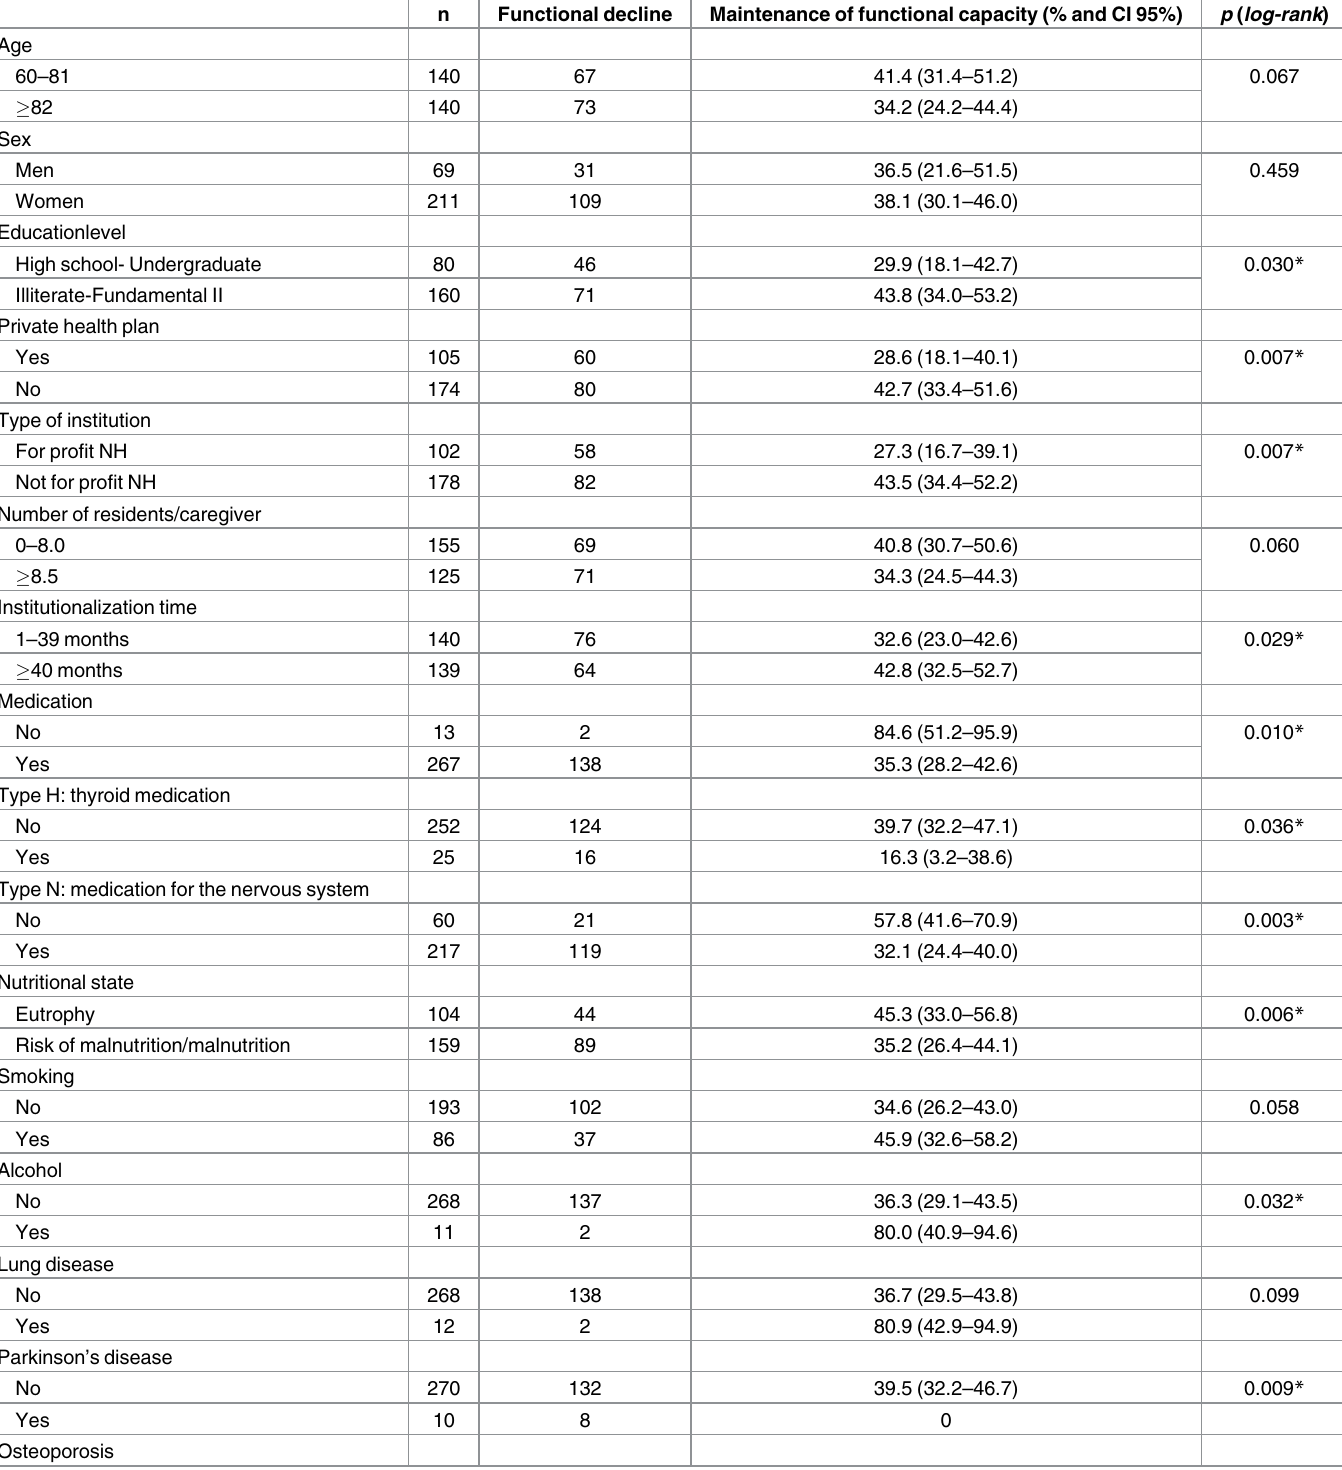
Table 3. Survival rates for maintenance time of functional capacity in relation to the covariables with p < 0.10, besides sex, in institutionalized older adults (n = 280) in the city of Natal/RN. Natal/RN, 2016.